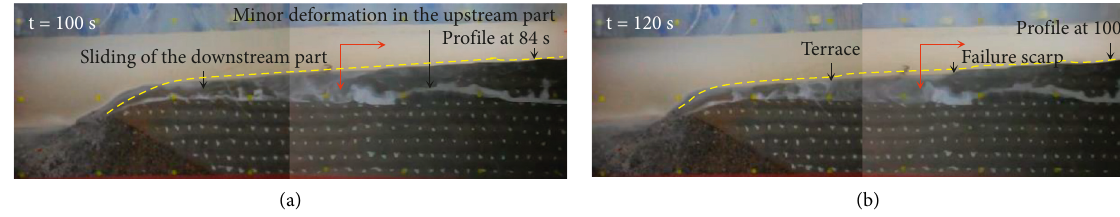
− d h , − 12mm h ,201mm and d h , − 144mm